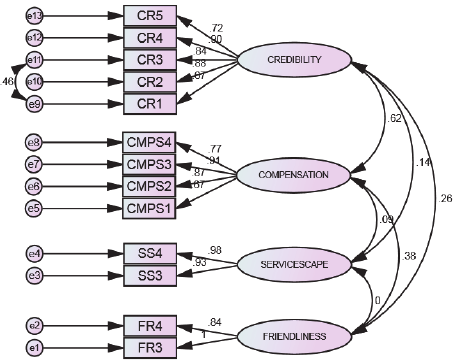
Fig. 3. CFA Model Development for measuring ISQ